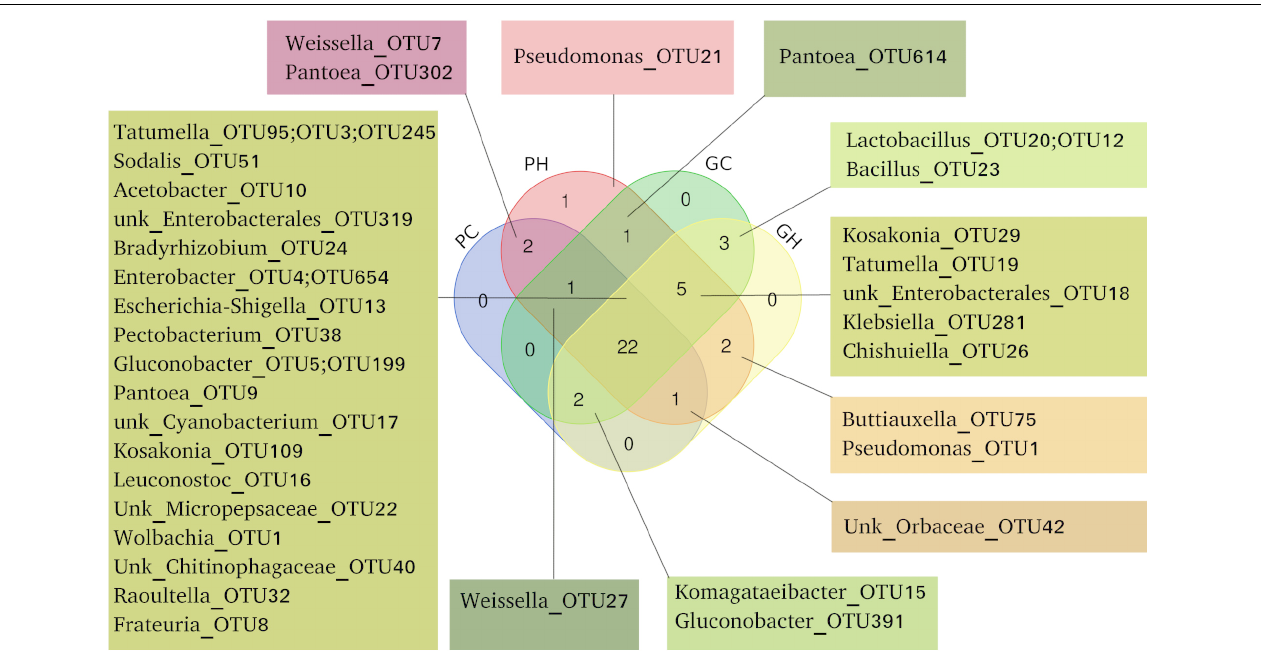
Tatumella-OTU3, Wolbachia-OTU1 and